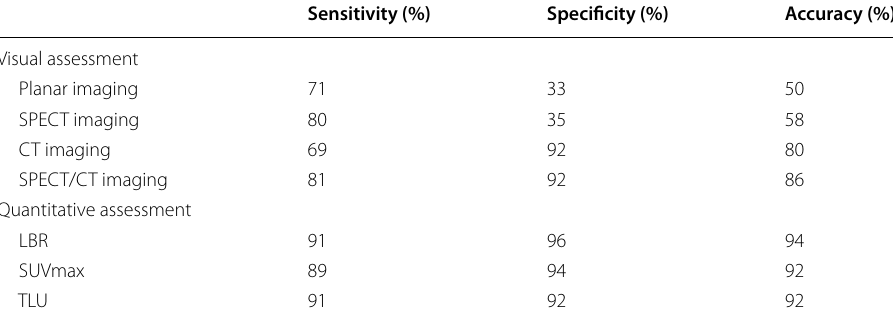
Table 5 Diagnostic accuracy of imaging modalities